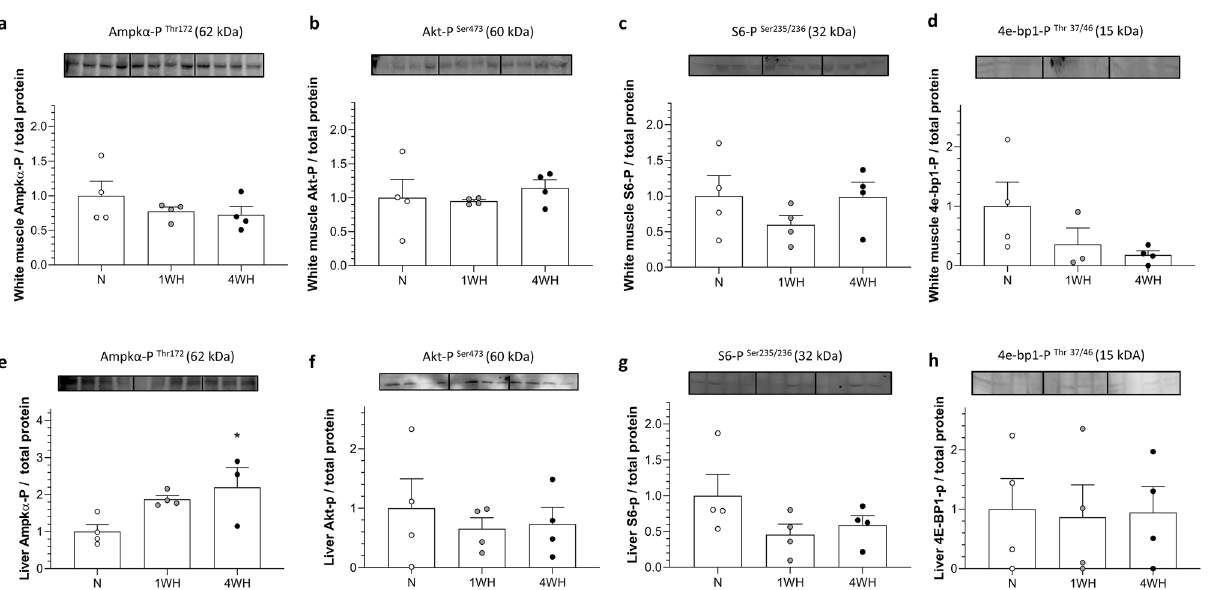
Figure 4. Relative abundance of phosphorylated (activated) proteins of Ampkα-P; panels ( a ) and ( e )) and proteins involved in the m-Tor signalling pathway (Akt-P; panels ( b ) and ( f )), S6-P; panels ( c ) and ( g )) and 4e-bp1-P; panels ( d ) and ( h ))] in liver and white muscle of normoxic controls (N), 1-week hypoxic (1WH) and 4-week hypoxic (4WH) goldfish. Protein size, specific phosphorylation sites and Blot images for all treatment groups are provided. All targets were quantified using secondary antibody infrared-based signals and normalized to total protein stained on the membrane. Values are means ± standard error of the mean (s.e.m.); sample size = 3–4 per group. Significant effects of chronic hypoxia are indicated as *( p <